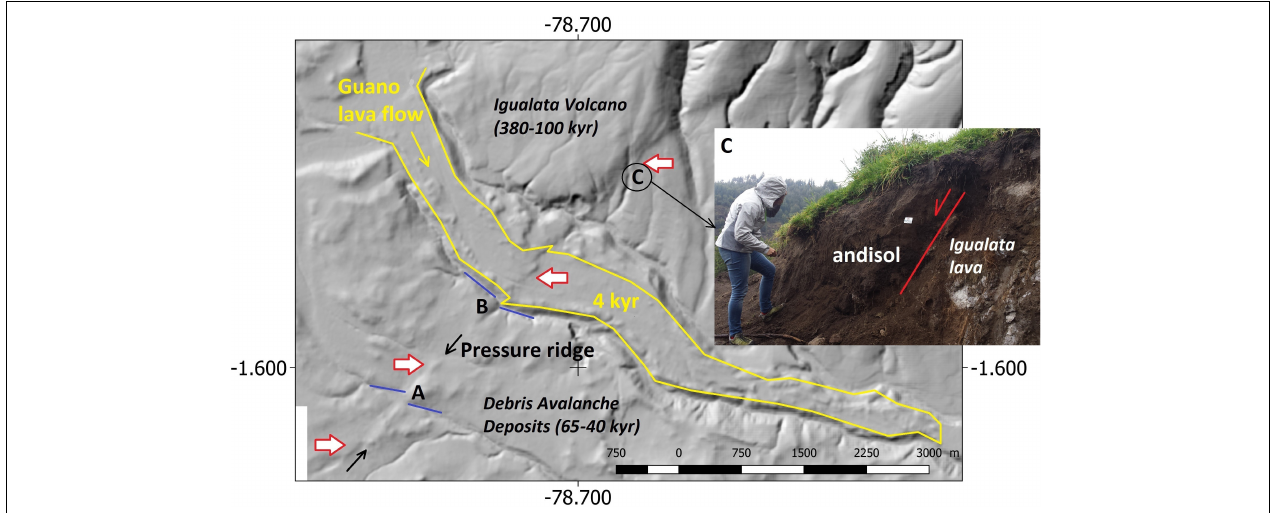
FIGURE 4 | Zoom-in in the San Andres village area. The fault intersects the Pleistocene and Holocene volcanic deposits of the Riobamba basin. From the SW to the NE, we observe first a pressure ridge within the Chimborazo Avalanche Deposits (age poorly constrained, probably around 45 ky) collocated with a lateral deflection (60–120 m) of a incised channel (label A). Second, the San Andres valley, within which the 4 ky old Guano lava flow is emplaced, is also dextrally displaced (label B, 60 m). Finally, the fault trace is inferred by the bumps on top of the Guano lava flow before it cuts the Igualata volcano slopes. Along the volcano slope, there are several places where we can observe horizontal deflections of incised streams and evidences of Holocene soil deformation (label C and insert C; plus pictures 2015-64&65.jpg in Supplementary Material ).